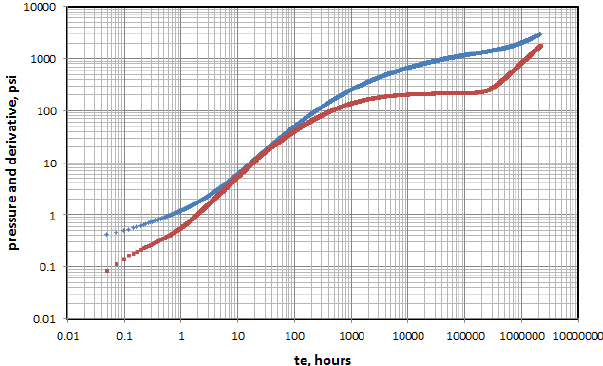
Figure 3—Simulated log-log diagnostic plot based on Larsen’s